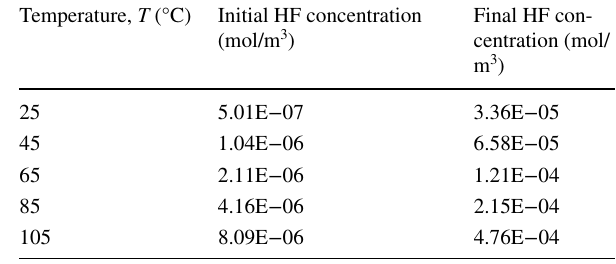
Table 6 Effect of temperature on HF concentration